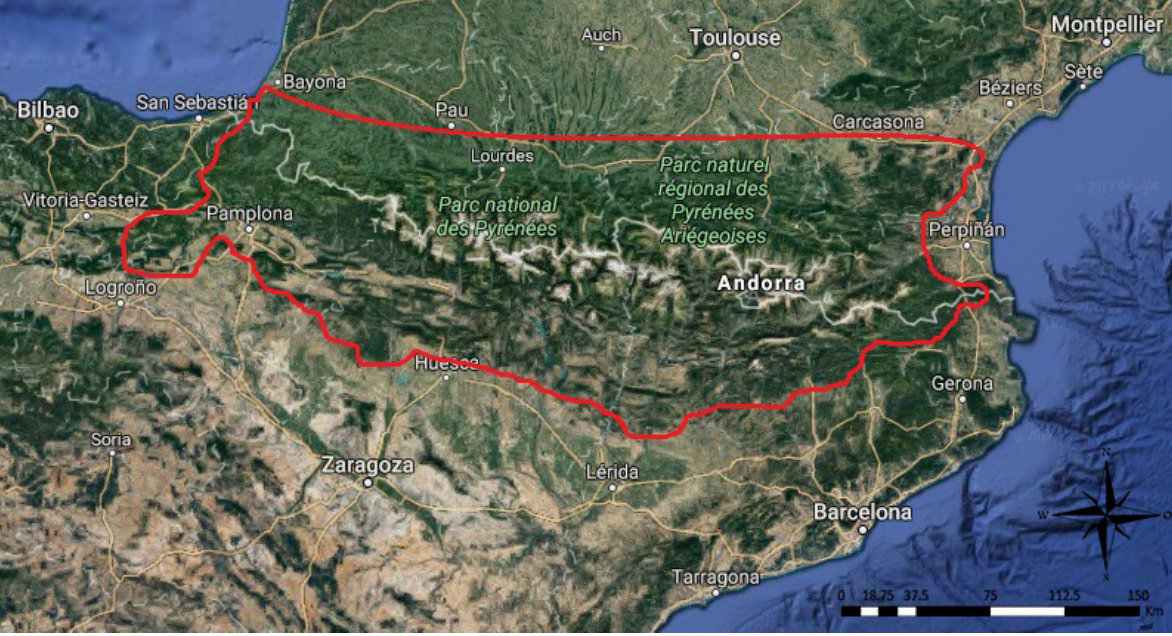
Figure 1. Map showing the delimitation of the Pyrenees.